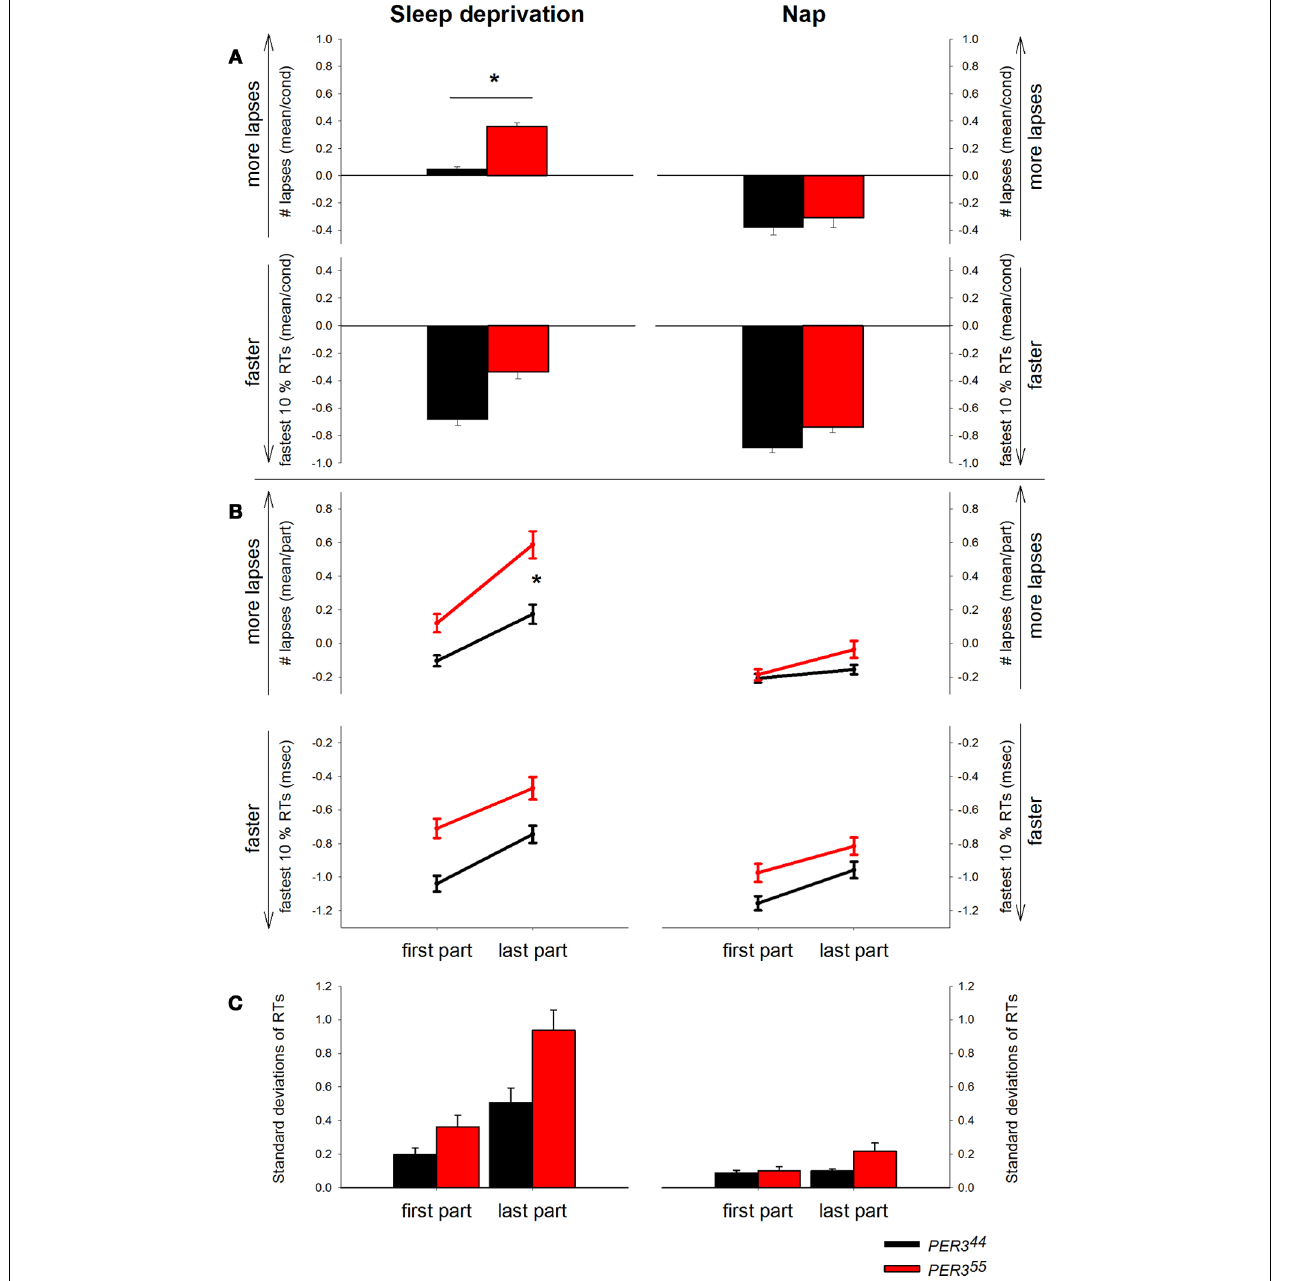
FIGURE 2 | Psychomotor Vigilance Task (PVT) performance displayed by genotype and condition. RT = Reaction time. (A) Mean number of lapses (transformed) and mean of the 10% fastest RT s ( z -scores) during sleep deprivation and during the nap protocol by genotype ( PER3 5 / 5 : red bars, PER3 4 / 4 : black bars). Asterisk represents p -value < 0.05. (B) PVT